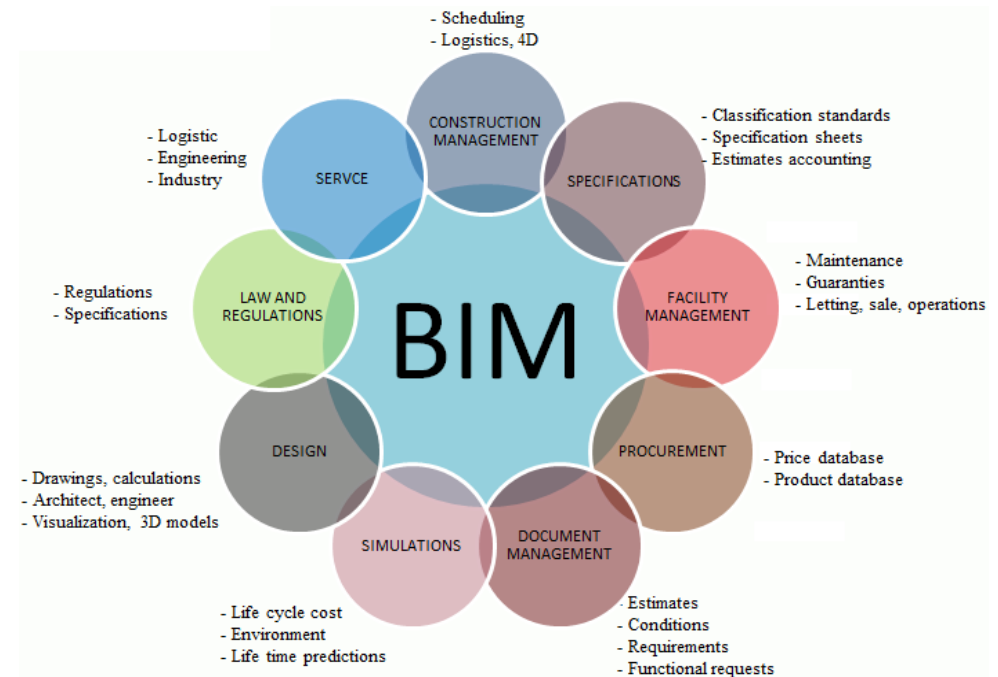
Figure 1. The use of BIM during the whole life cycle of a building. Source: [17] .